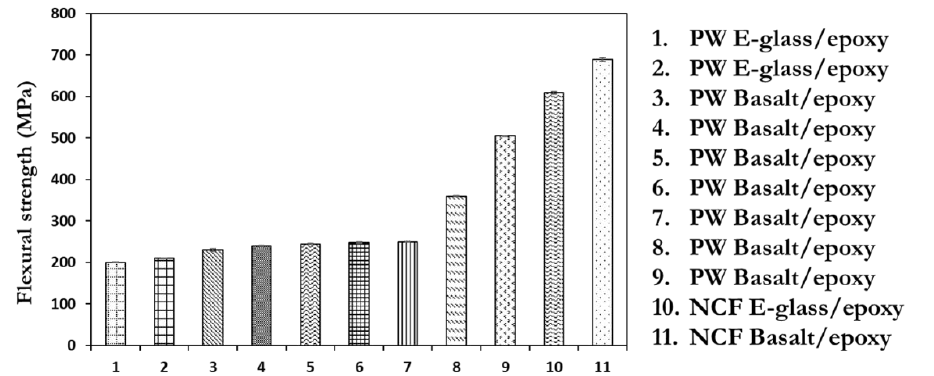
Figure 3. A comparison of flexural strength of Basalt/epoxy composite against composites manufac- tured using E-glass based reinforcement [1—Scalici et al. [92], 2—Lopresto et al. [82], 3—Bulut [88],